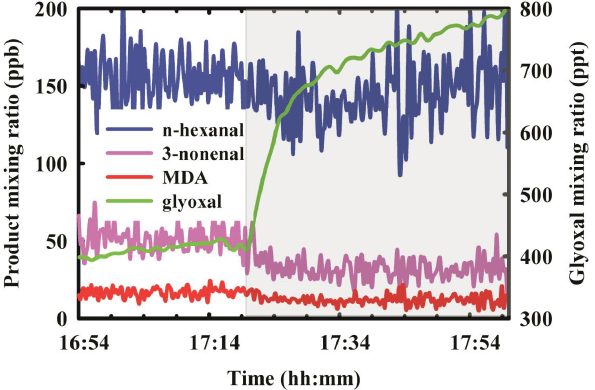
Fig. 9. Flow tube results when a UV lamp is turned on (in the shaded region) to form OH in a second flow tube in series downstream of the LA oxidation flow tube.